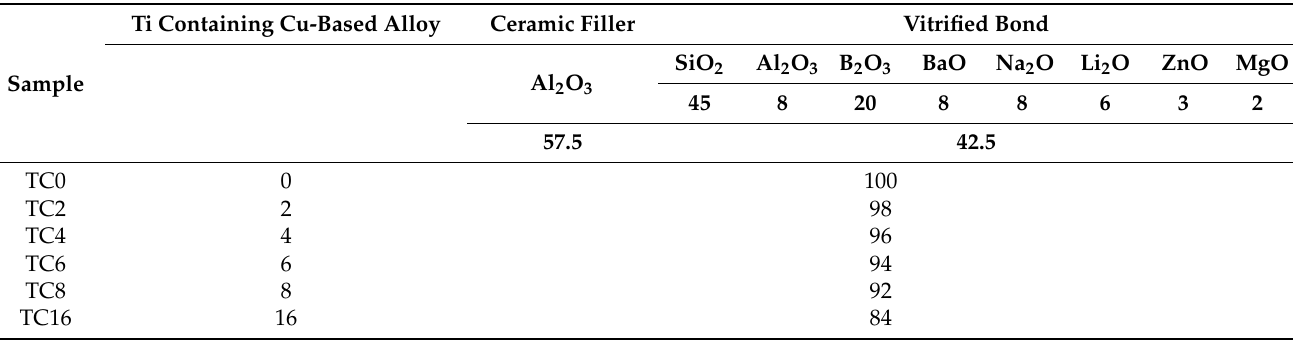
Table 1. Compositions of the TC composites